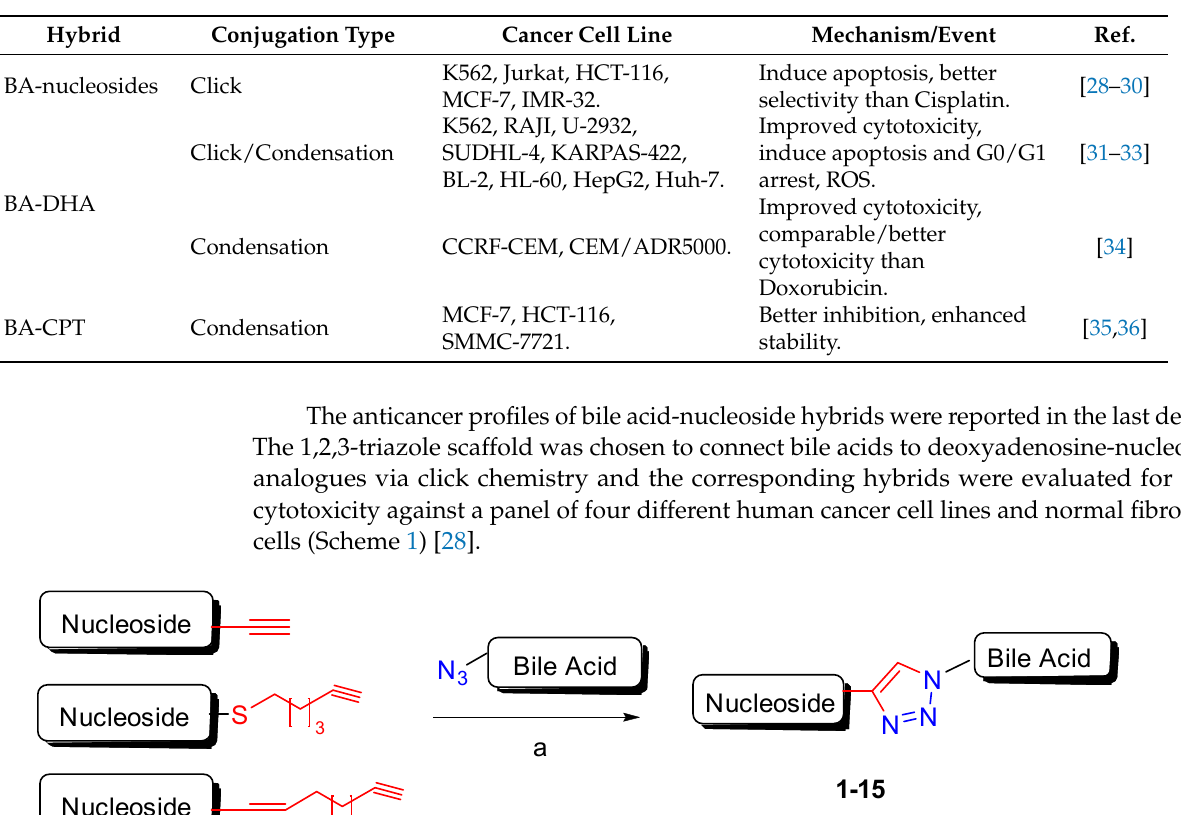
Table 1. Summary of BA